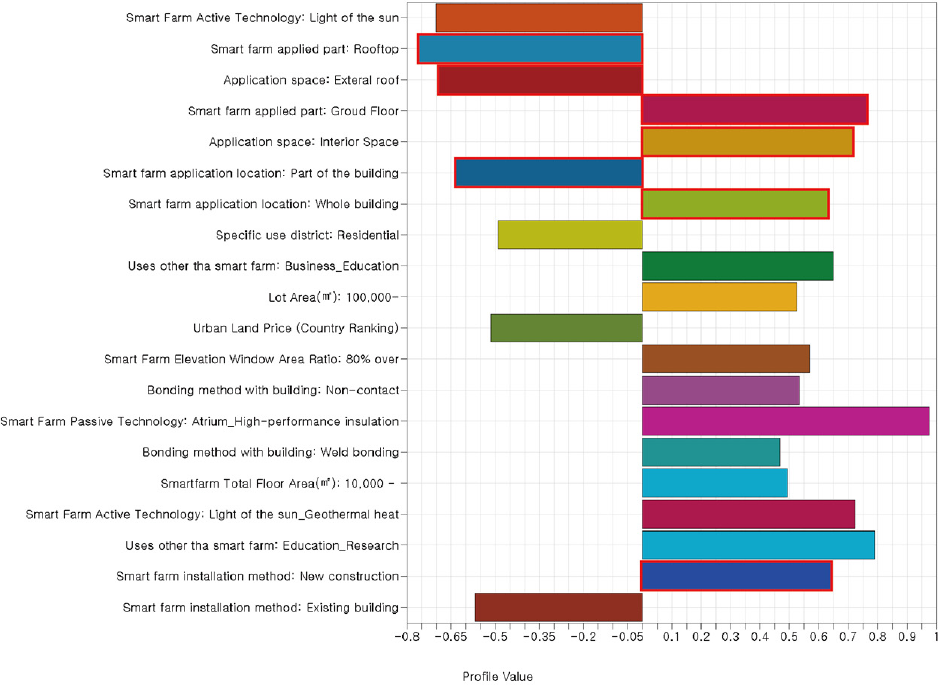
Figure A1. C1. Figure A1.